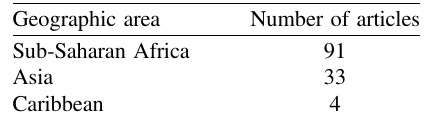
Table 2. Geographic origin of articles from LIC by region, 2007 – 2017. The total number of countries is 128 because 5 of 121 articles were studies conducted across more than one LIC.